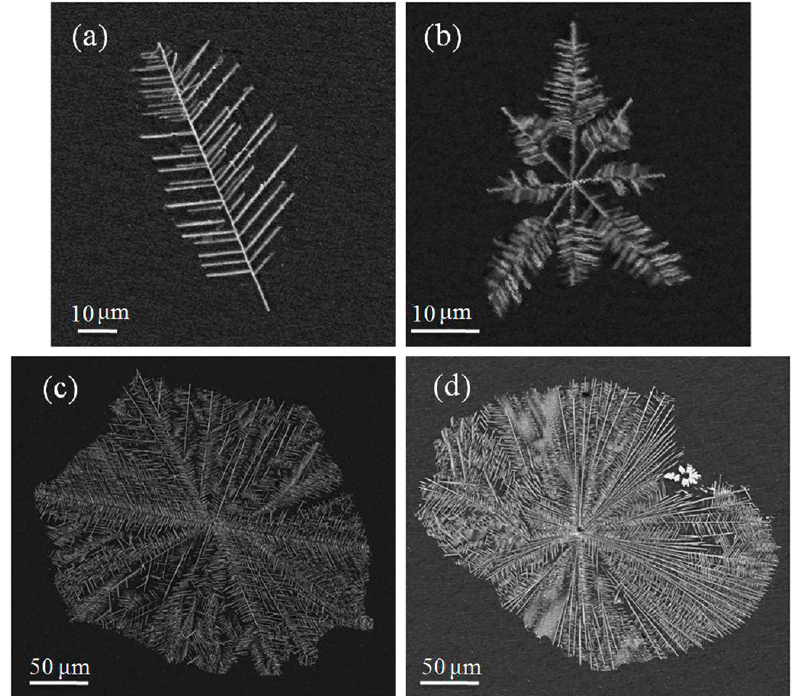
Figure 13. SEM BSE morphology of Al 6 Mn dendrites in suction casting Al–Mn alloys: ( a ) Al–6 wt.% Mn alloy; ( b ) at the edge of the cross-section of the sample in the Al–8 wt.% Mn alloy; ( c ) at the center of the cross-section of the sample in the Al–8 wt.% Mn alloy; ( d ) at the center of the cross-section of the sample in the Al–10 wt.% Mn alloy.